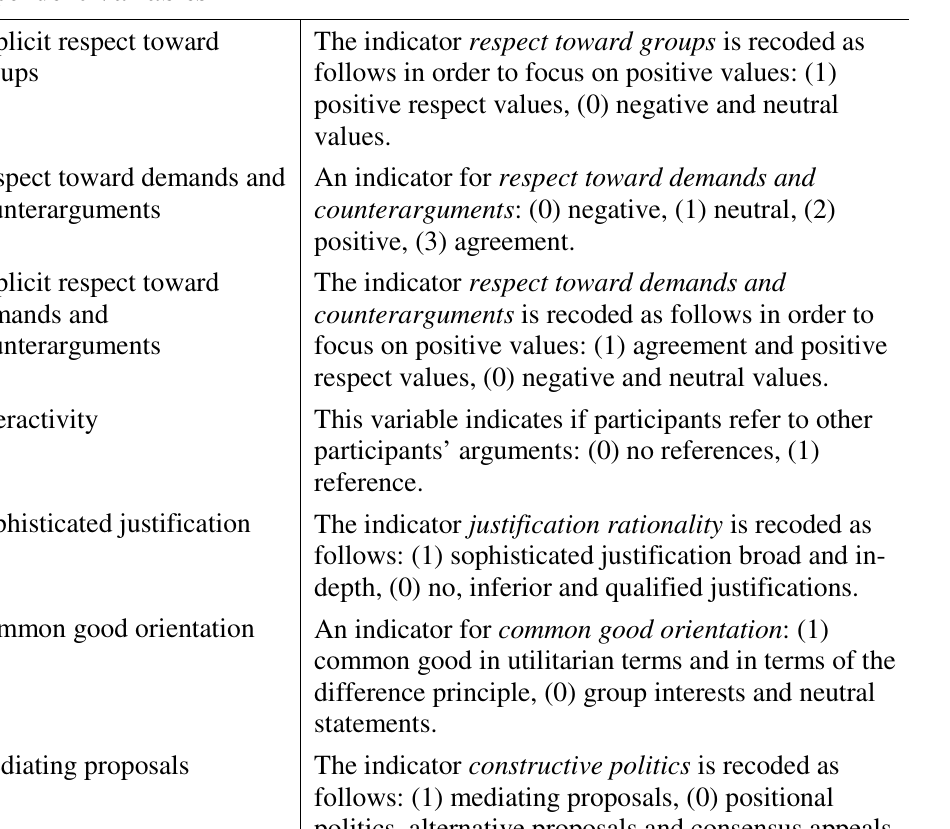
Table 2: Variable